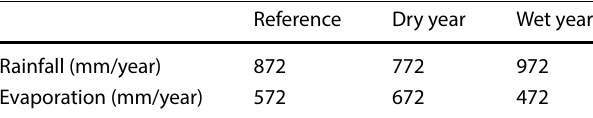
Table 6 Reference rainfall and evaporation as compared to a period of wet and dry years